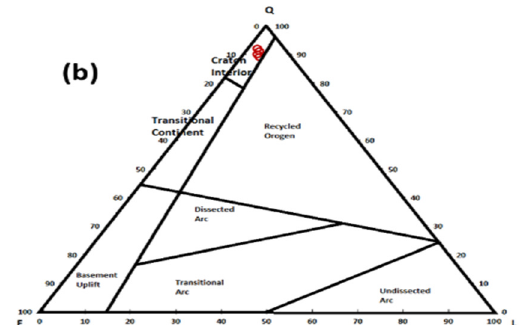
Fig. 6 (a) Quartz-Feldspars-Lithic (Qfl) Ternary Diagram of Nari Sandstone Sample Adopted From Folk (1974). (b) (Quartz- Feldspars-Lithic) Ternary Diagram Showing the Sandstone Composition Adopted from Dickinson et. al. [16]